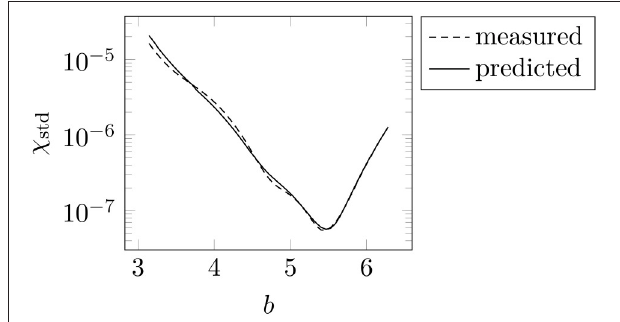
FIGURE 3 | Predicted and measured errors χ std for different values of the shape parameter b : ( b , b , b ) . We choose the parameters α = (32 , 32 , 32) , σ (1 , 1 , 1) and m 3 . (Window function: Bessel). M = = =